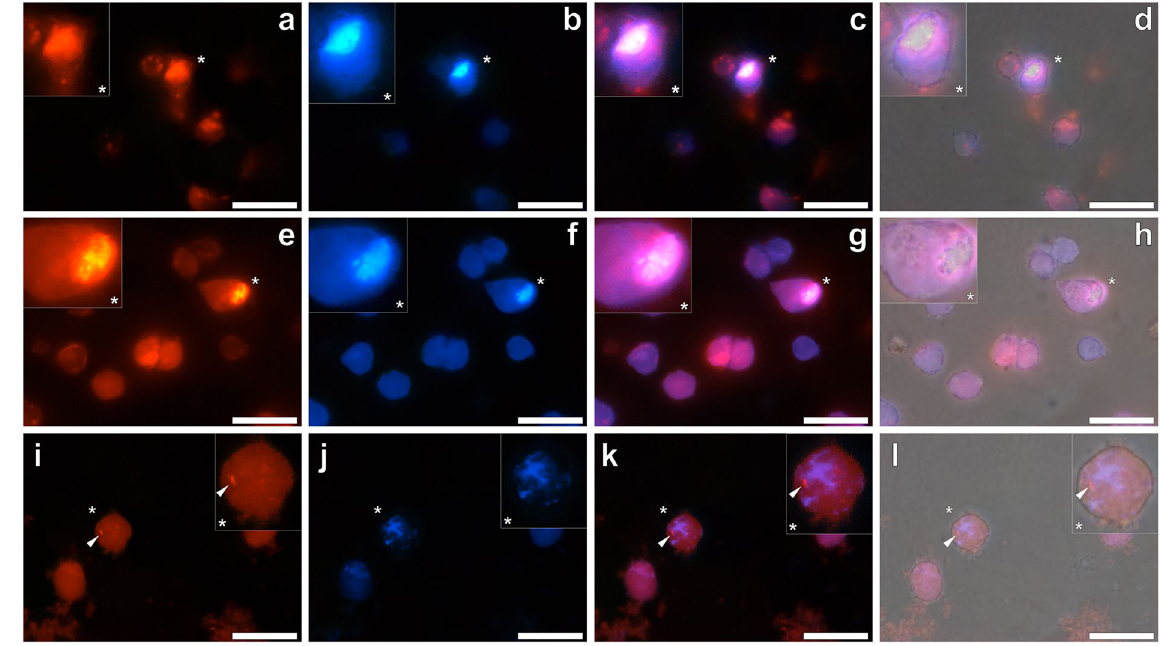
Figure 3. Representative fluorescence microscopy of whole THP-1 cells cultured for 24 h in R10 medium in the presence of a simulated vaccine formulation. Vaccine treatments were prepared via the addition of 8 μ M A β 42 and 25 or 12.5 μ g/mL ABA to complete R10 medium. Following 21 h incubation at 37 °C, 20 μ M ThT and 100 μ M lumogallion was added to the respective treatments and incubated for a further 3 h, prior to their 1:1 addition to THP-1 cells. Cells co-cultured for 24 h with simulated vaccine treatments contained 4 μ M A β 42 and ( a–d ) 12.5 μ g/mL Alhydrogel ® (Brenntag), ( e–h ) 12.5 μ g/mL Imject Alum ™ (Pierce, Thermo Scientific) or ( i–l ) 6.25 μ g/mL Adju-Phos ® (Brenntag). Cells were fixed in 4% w/v PFA, washed in 50 mM PIPES buffer, pH 7.4 before mounting with Fluoromount ™ (Sigma Aldrich) on poly-lysine coated slides. Lumogallion (orange) ( a , e and i ) and ThT (blue) fluorescence ( b , f and j ) is depicted (Olympus single bandpass U-WMBV2 filter cube) with magnified inserts denoted ( * ). Merged lumogallion and ThT channels ( c , g and k ), combined with the light overlay ( d , h and l ) are also depicted. Arrows highlight discreet adjuvant particles. Magnification X 1000, scale bars: 20 μ